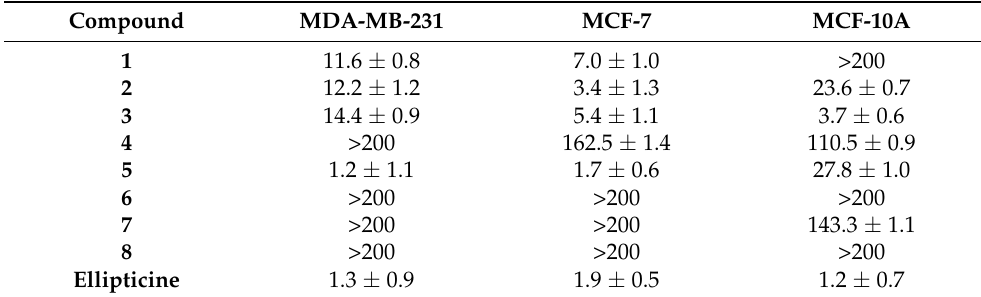
Table 1. IC 50 values of compounds 1 – 8 and Ellipticine, expressed in µ M. The means ± standard deviations are shown. The experiments were performed in